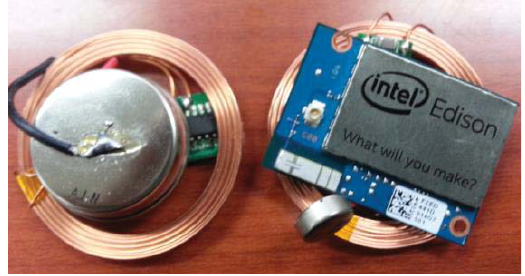
Figure 1. Prototype of proposed cross leg detector with